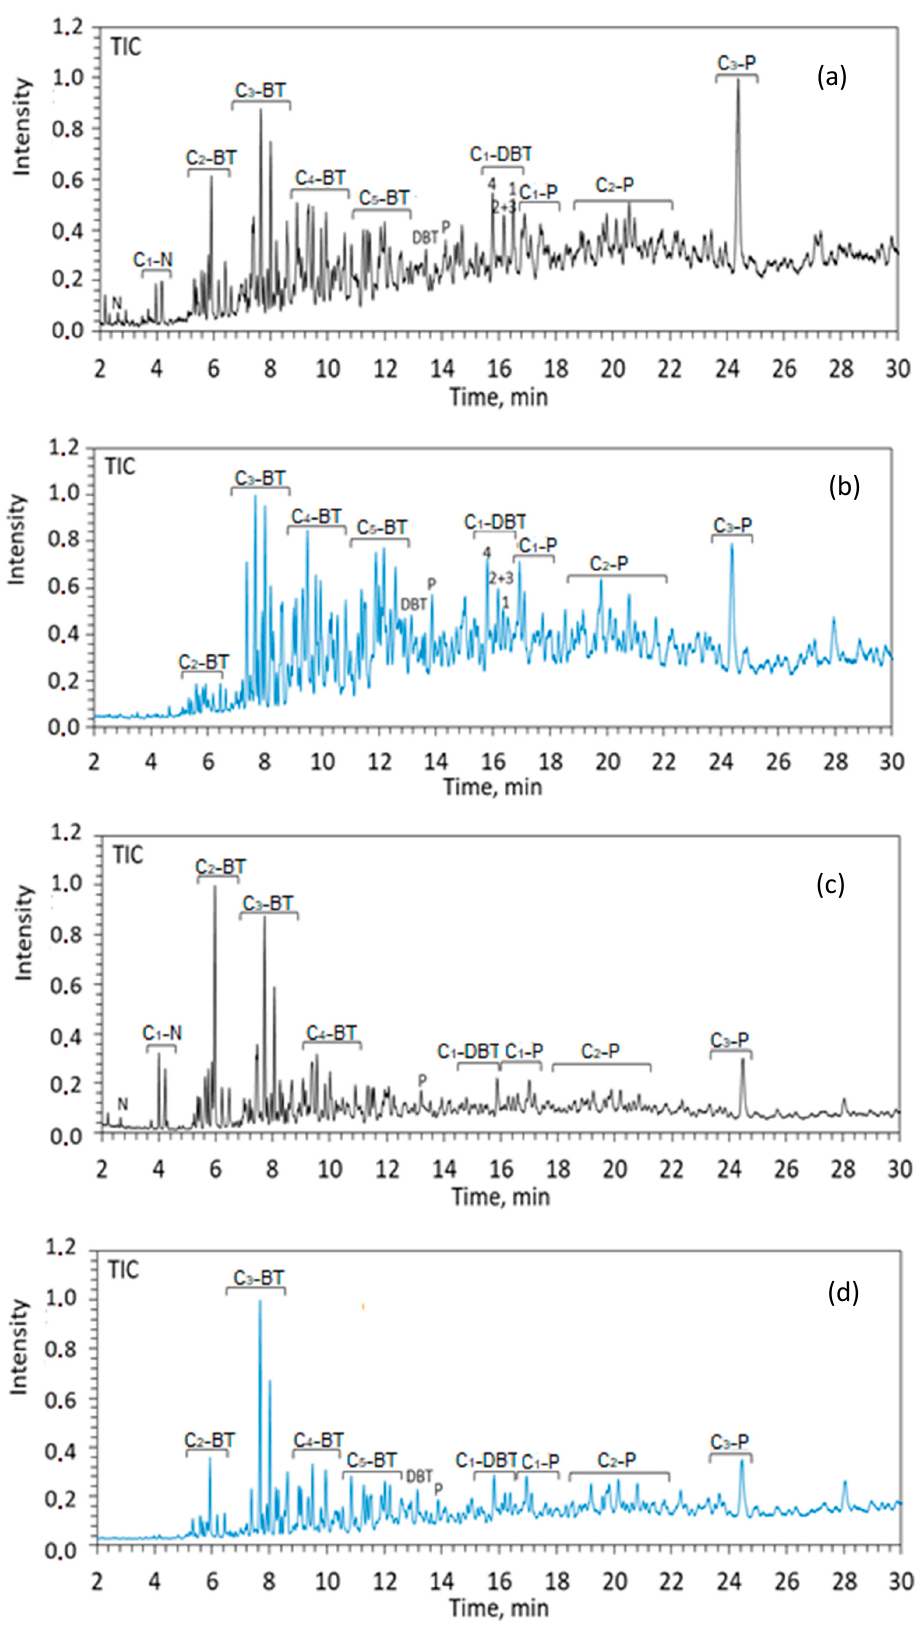
Figure 5. TIC of aromatic fractions of shale oil from the rock samples of Zelenogorskaya and Berezovskaya areas before ( a , c ) and after ( b , d ) hydrothermal experiments. N—naphthalene, P—phenanthrene, DBT—dibenzothiophene and BT— benzothiophene, n—number of carbon atoms in alkyl substitutes of C n